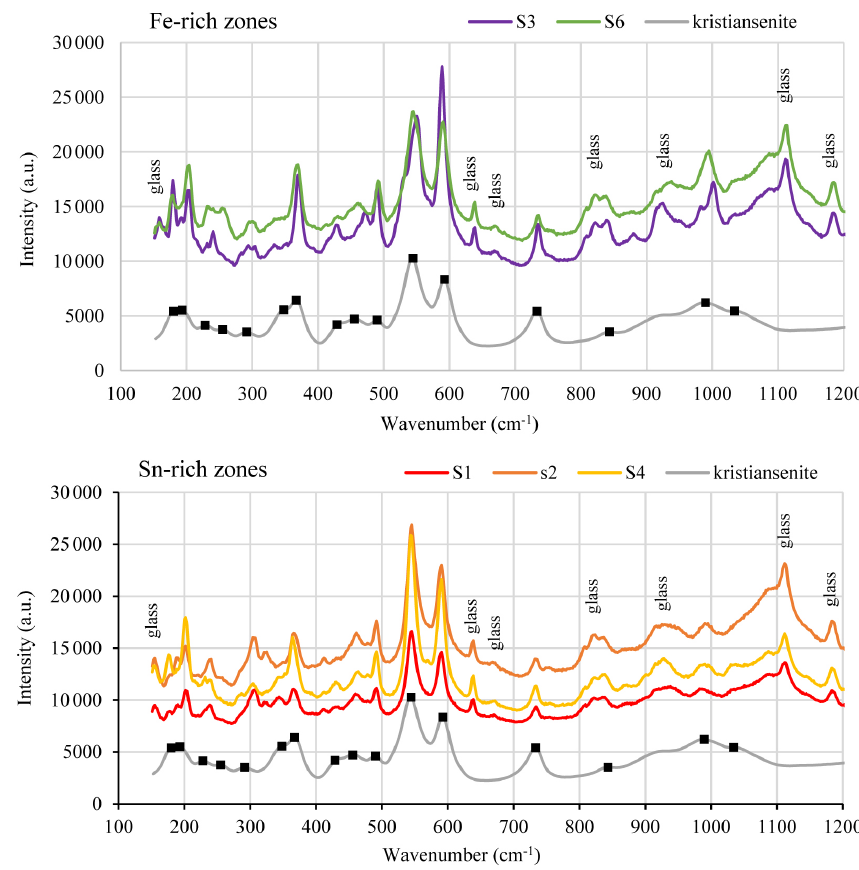
Figure 5. Raman spectra from Fe-rich and Sn-rich areas of silesiaite crystals. Raman spectrum of kristiansenite is also shown (Ruff ID = R090022). Glass signifies intensities corresponding to glass